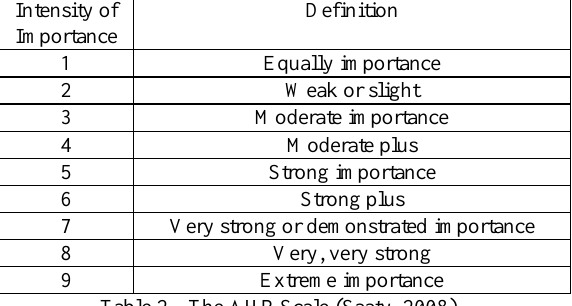
Figure 1. SACO vs Dijkstra – paths (Mariusz D., 2012) The multiple shortest path of Dijkstra’s algorithm